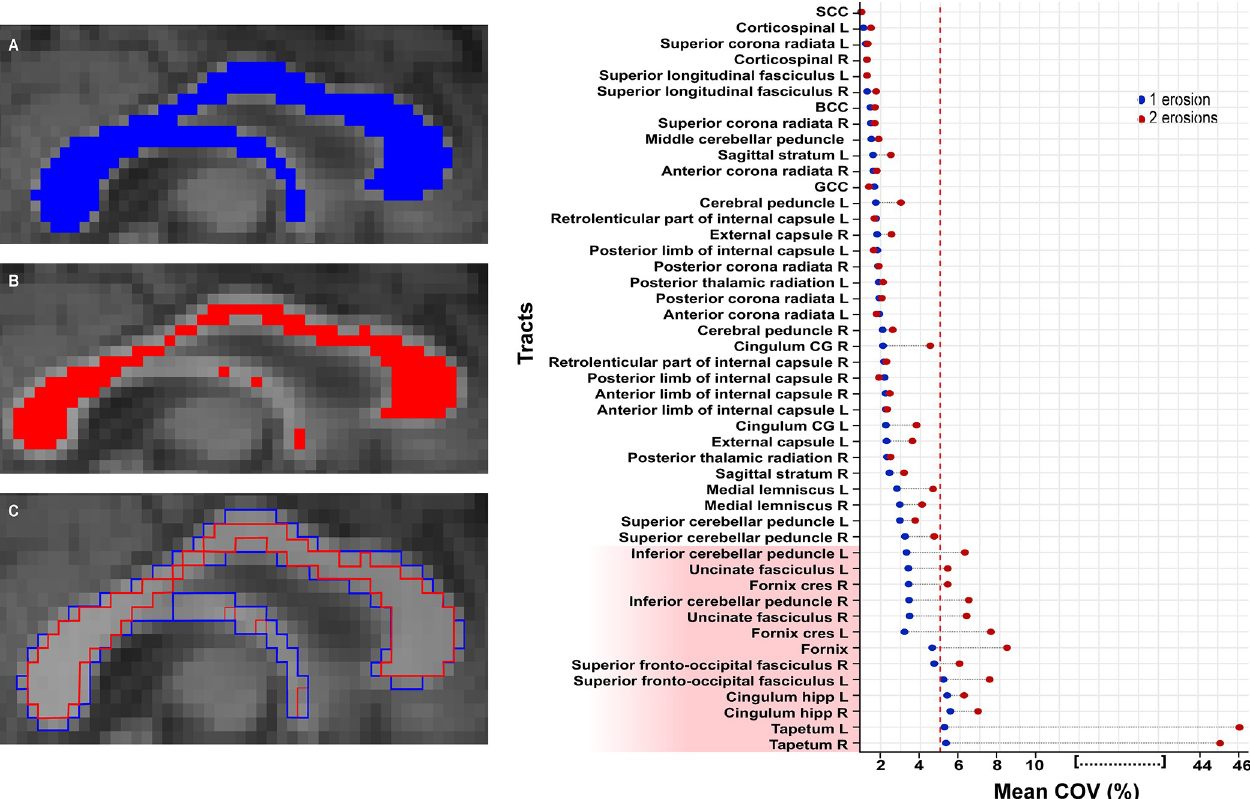
Fig 6. Tracts erosion and coefficient of variation. (Left) Direct comparison of segmentation and voxel exclusion using (A) an n-pass filter of 1 or (B) an n- pass filter of 2 in the fornix and the three parts of the corpus callosum, and (C) the difference between the two erosion filters. (Right) Mean intra-subject COV per tract values following segmentation of 47 tracts using an n-pass filter of 1 (blue) or 2 (red). Cut-off (red dotted line) is at 5% variation for any of the two erosions (if variation of either 1 or 2 erosions is higher than 5%). Tracts highlighted in red are rejected. BCC = body of corpus callosum, GCC = genu of corpus callosum, SCC = splenium of corpus callosum.